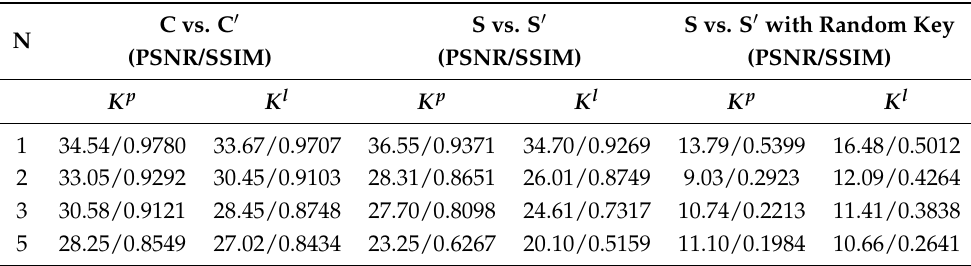
Table 3. Quantitative results for both K p and K l according to N. There are also results of revealed secret images with random